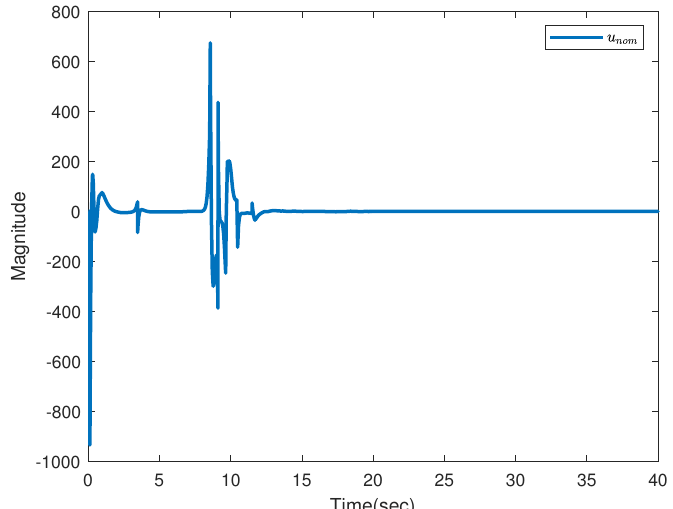
Figure 7. Time history of the nominal control input u d 2 based on the estimates produced by the observer (16).